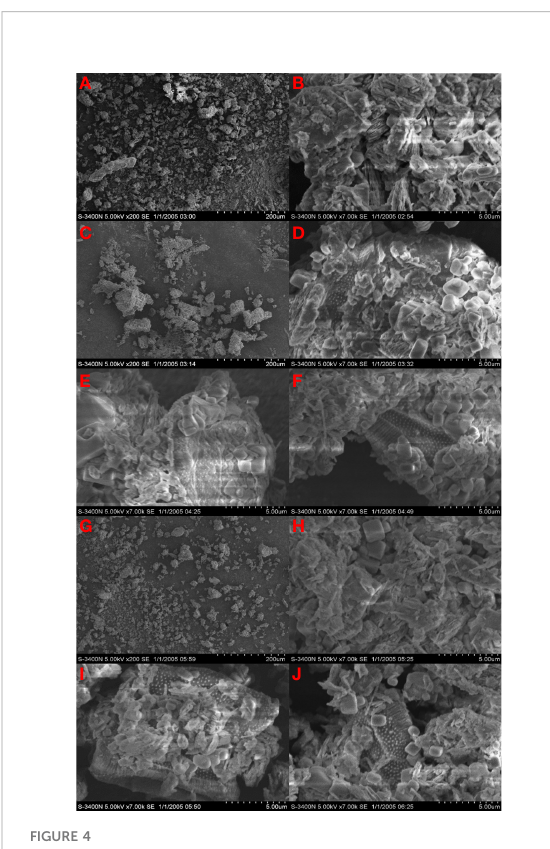
FIGURE 4 SEM images of fl ocs in the kaolin, MP and MH group under static conditions (A – J) .